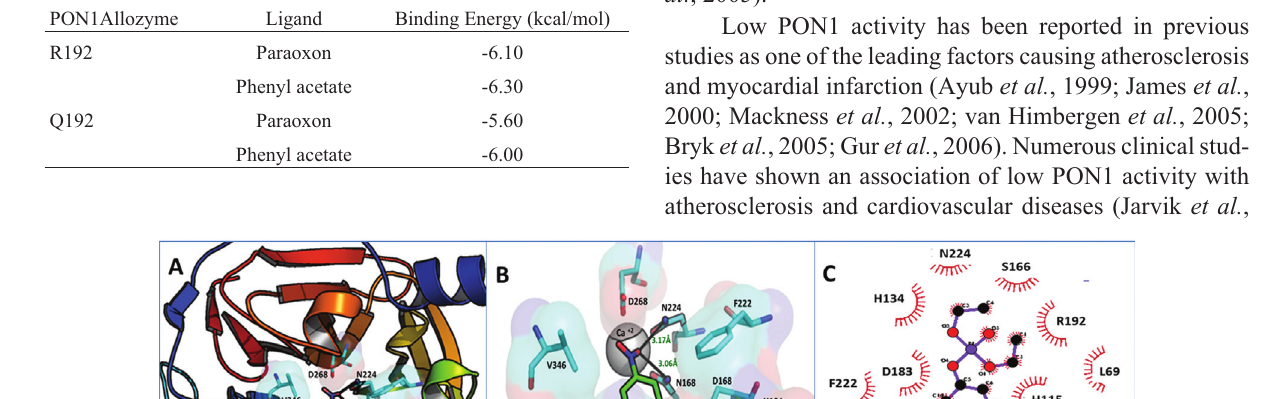
Table 3 - Binding affinities of PON1 Q192 and R192 against paraoxon and phenyl acetate.